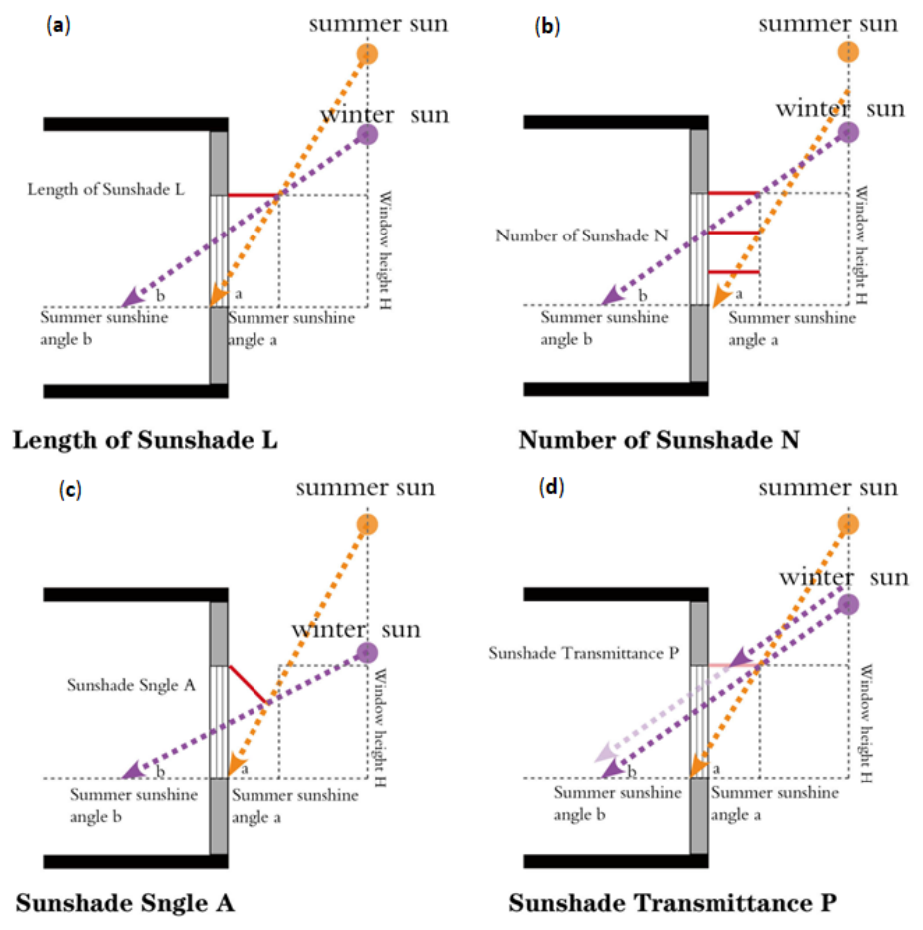
Figure 9. The shading parameters: length of sunshade L ( a ); some sunshade N ( b ); sunshade angle A ( c ); sunshade transmittance P ( d ).